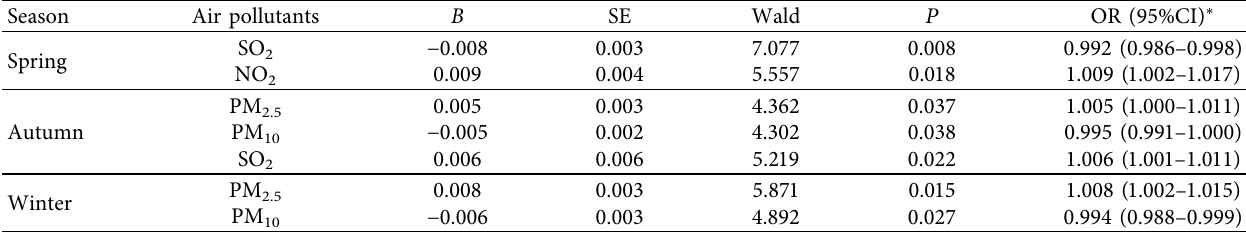
Table 3: Multifactorial models to assess the relationship between hospital admissions of COPD and concentrations of air pollutants in different seasons.